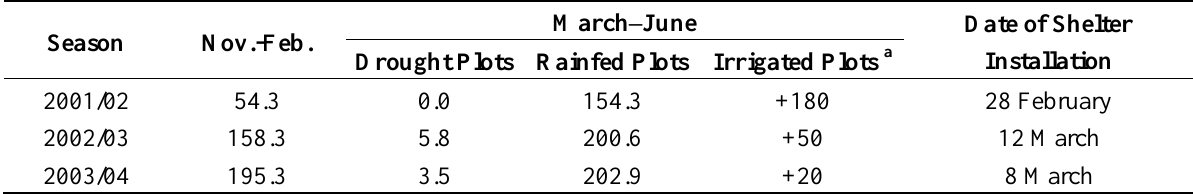
Table 6. Precipitation (mm) during the winter period (November–February) and vegetative phase (March–June), including irrigations, and installation dates for the rain-out